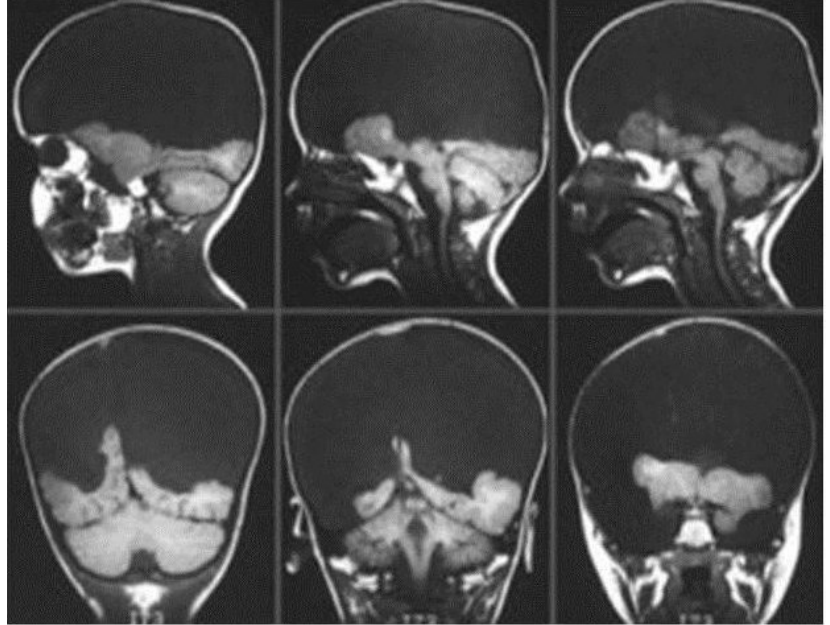
Figure 7. A typical hydranencephalic brain. (Reprinted with permission of the American College of Radiology [40]. No other representation of this material is authorized without expressed, written permission from the American College of Radiology).